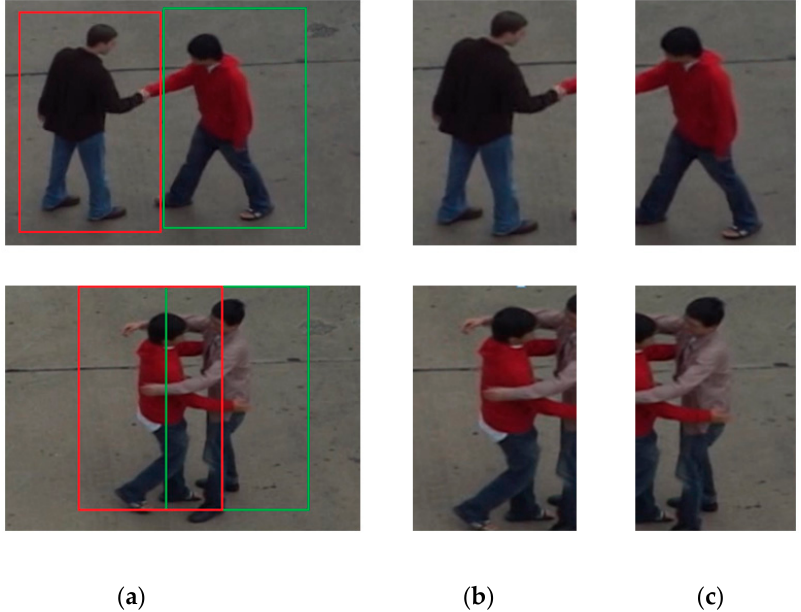
Figure 3. Video individual detection diagram: ( a ) Original video; ( b ) Individual video (left); ( c ) Individual video (right).